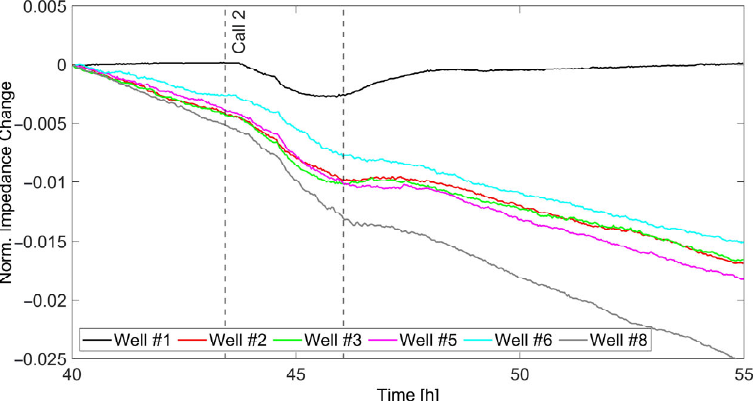
decreased during the phone call and started to increase after it was switched off. The ca ‐